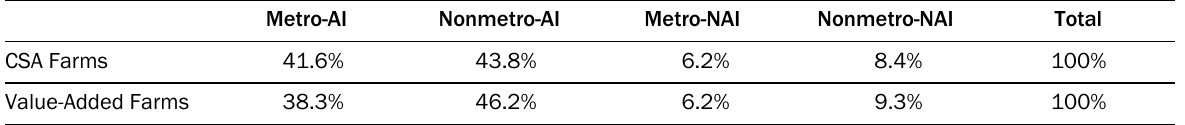
Table 9. CSA and Value-Added Farms by County Type, 2007